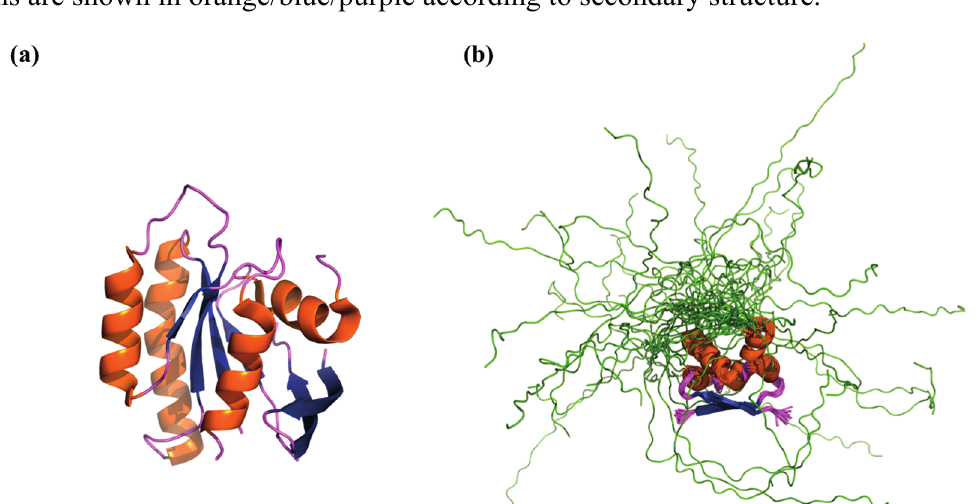
Figure 3. Varied degree of order in proteins ( a ) Crystal structure of the protein H-Ras, solved in complex with GTPase-Activating Protein (not shown, PDB ID: 2x1v) [56]. H-Ras is a folded protein containing a number of loops (purple) that have well-defined B-factors. These loops have no regular secondary structure yet they are ordered in the sense that they have well defined three-dimensional coordinates. Ordered regions of the protein that have regular secondary structure are shown in orange (helices) and blue (sheets); ( b ) NMR ensemble of the CcdA dimer (PDB ID: 2h3a), a protein with both an ordered region and an IDR [57]. The intrinsically disordered C -terminal tail (shown in green) populates a large number of structurally dissimilar states. Each of the potential C -terminal conformations is depicted as a distinct backbone trace (green), and the ordered regions are shown in orange/blue/purple according to secondary